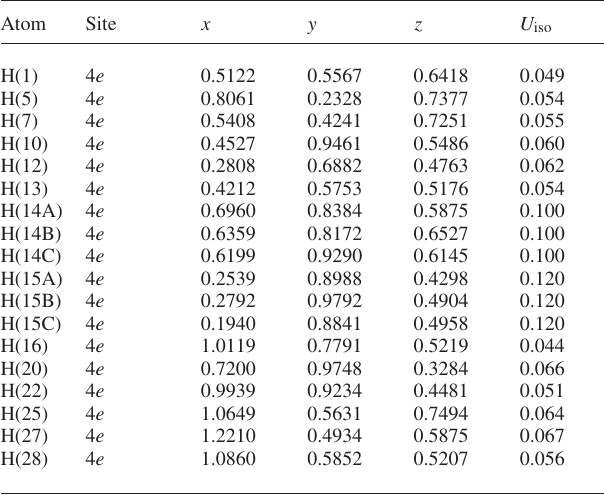
Table 2. Atomic coordinates and displacement parameters (in Å 2 )